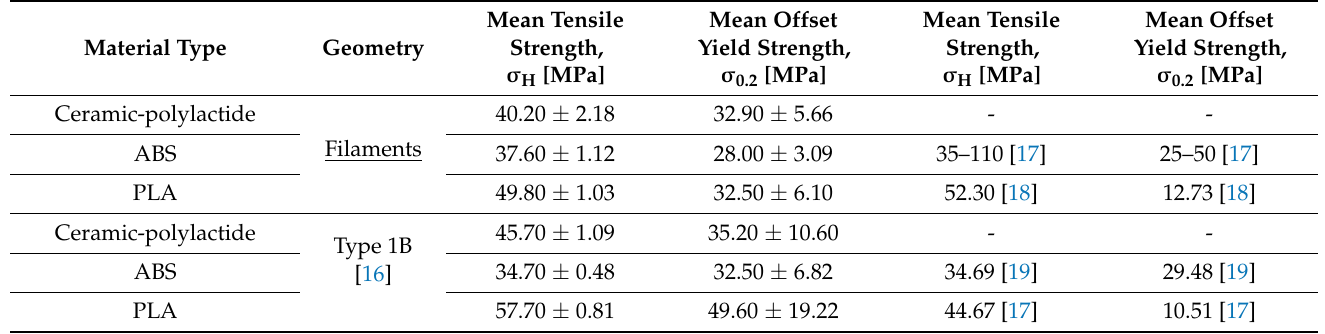
Table 2. Mean tensile and offset yield